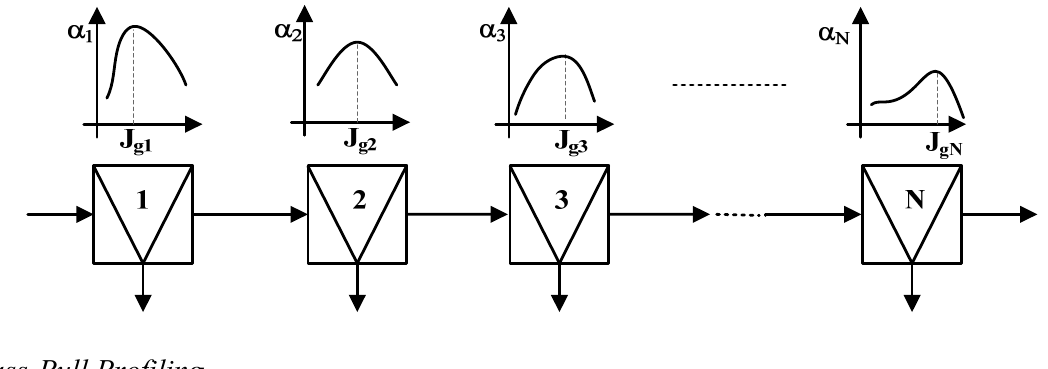
Figure 2. PAR air profiling strategy applied to a bank of N cells.